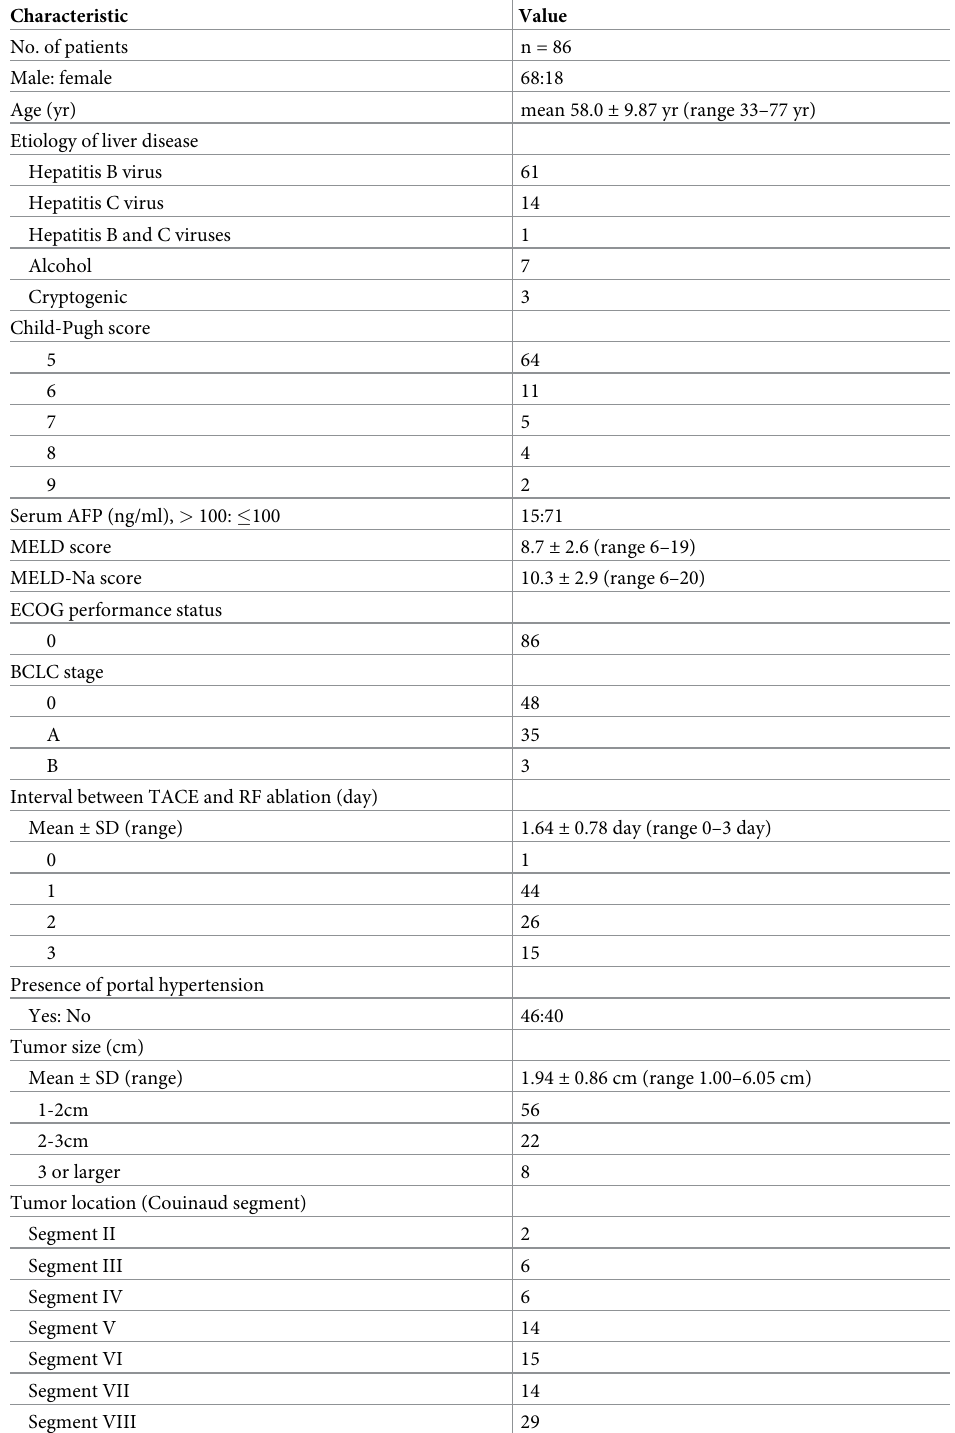
Table 1. Characteristics of study